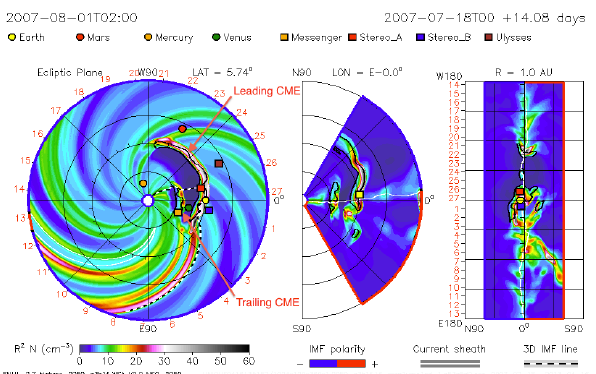
Fig. 12. The CCMC’s ENLIL with a cone model simulation results. The estimated arrival time of the leading partial halo CME at Venus is approximately 02:00 on 1 August 2007 using the above simula- tion results. The red arrows mark the leading and trailing